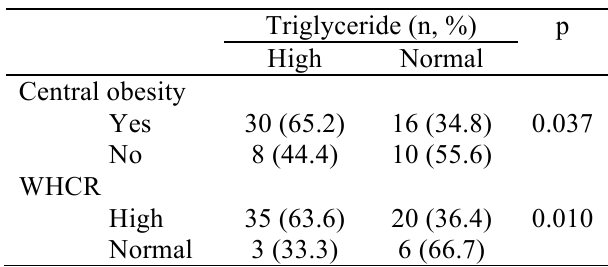
Table 3b Association between central obesity and WHCR to LDL-cholesterol